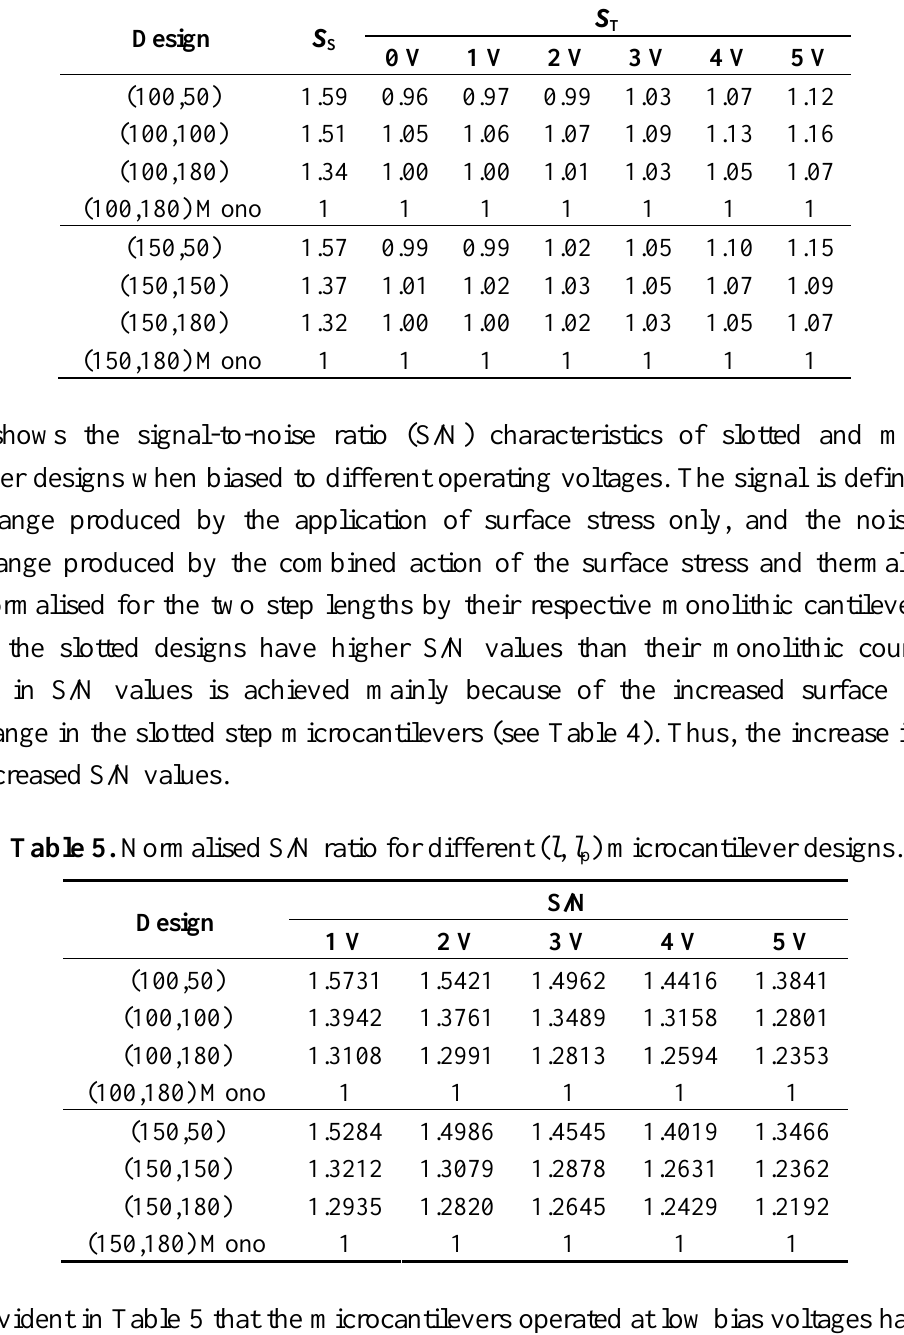
) microcantilever designs. p